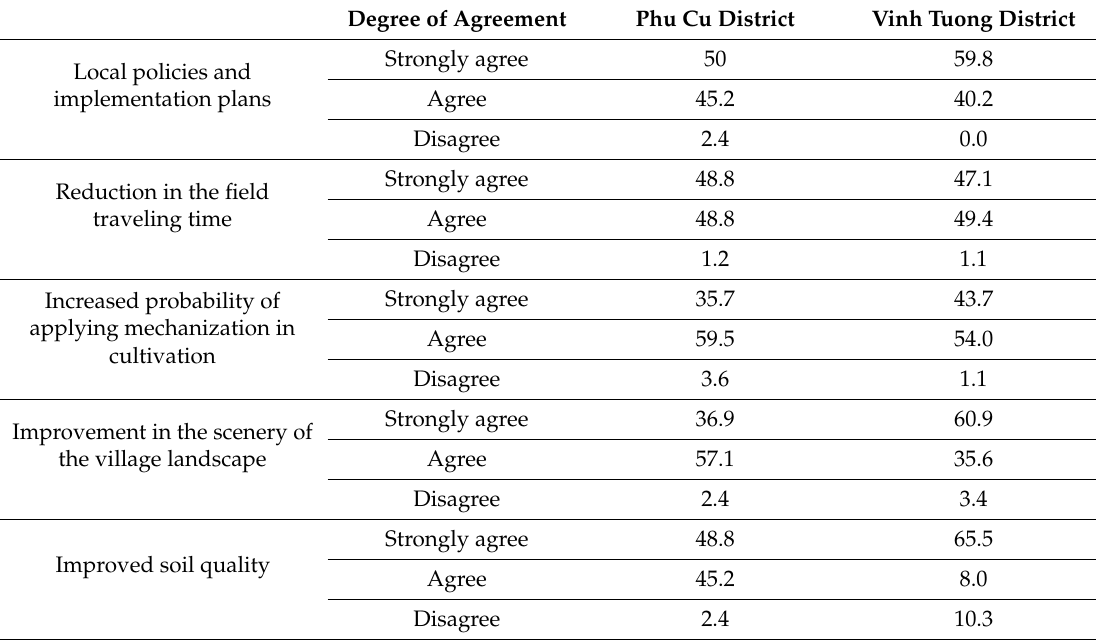
Table 11. Percentages of farmers agreeing with the e ff ectiveness of land